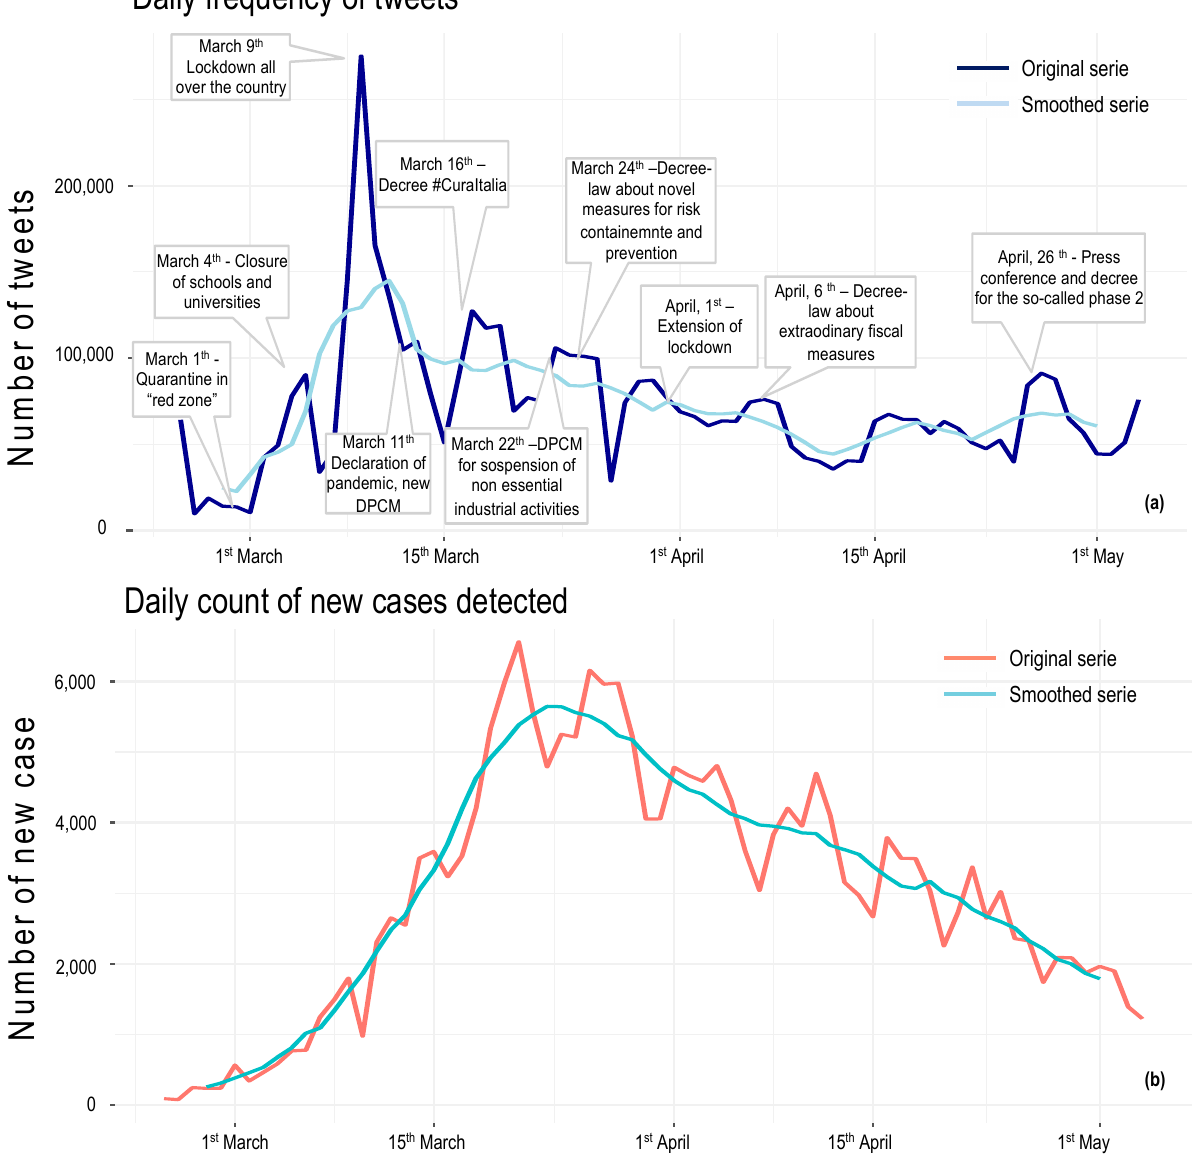
Figure 1. Daily counts of tweets and daily counts of newly detected COVID-19 cases. ( a ) Daily counts of tweets posted throughout the time frame with notes about national key events. ( b ) Timeline of newly detected cases. In all panels, national key events are highlighted, and the original time-series of row count and the smoothed series were obtained using simple moving average (MA) based on 7 days to remove peak and the “weekend effect”. During the study period, the mean daily number of posts increased from 21,720 in week 1, tripling in week 2, and doubling again in week 3 when the national lockdown was imposed. The mean number of posts slightly decreased in weeks 4 and 5, with around 50,000 to 60,000 posts per day in the following weeks (Supplementary Table